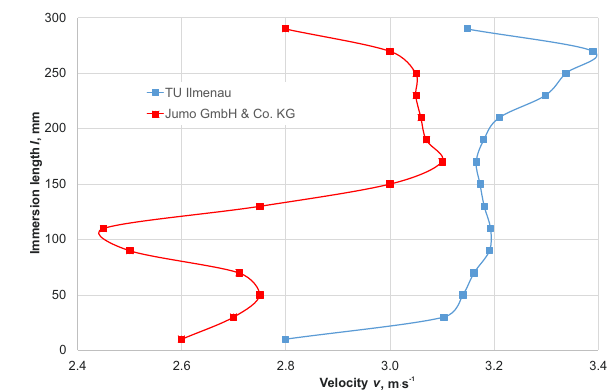
Table 2. Test conditions.